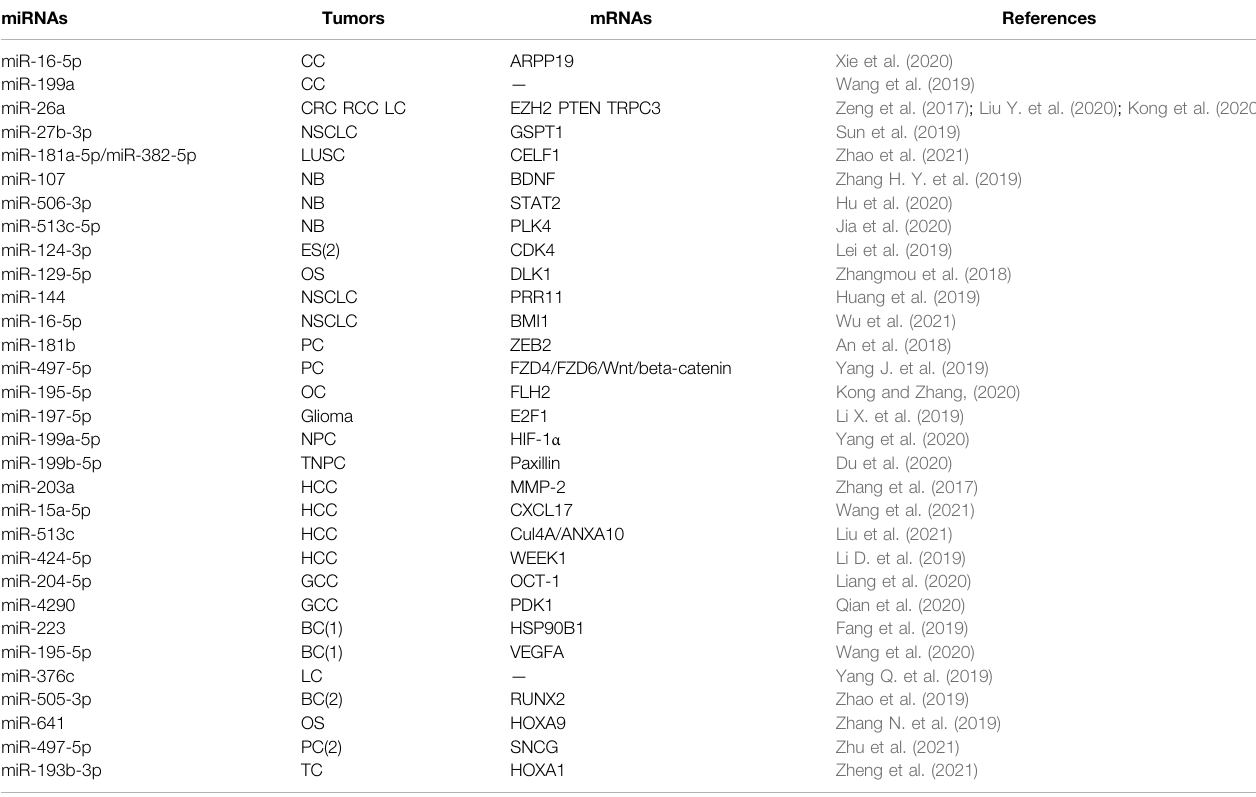
TABLE 1 | miRNAs sponged by lncRNA DLX6-AS1 and miRNA targets in various tumors. miRNAs Tumors